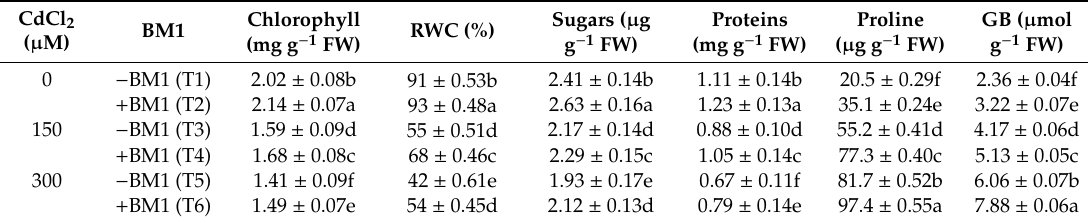
Table 3. chlorophyll content, leaf relative water content (RWC), total soluble sugars, protein, proline and glycine betaine (GB) contents in leaves of un-inoculated and inoculated soybean plants with Serratia marcescens BM1 under Cd